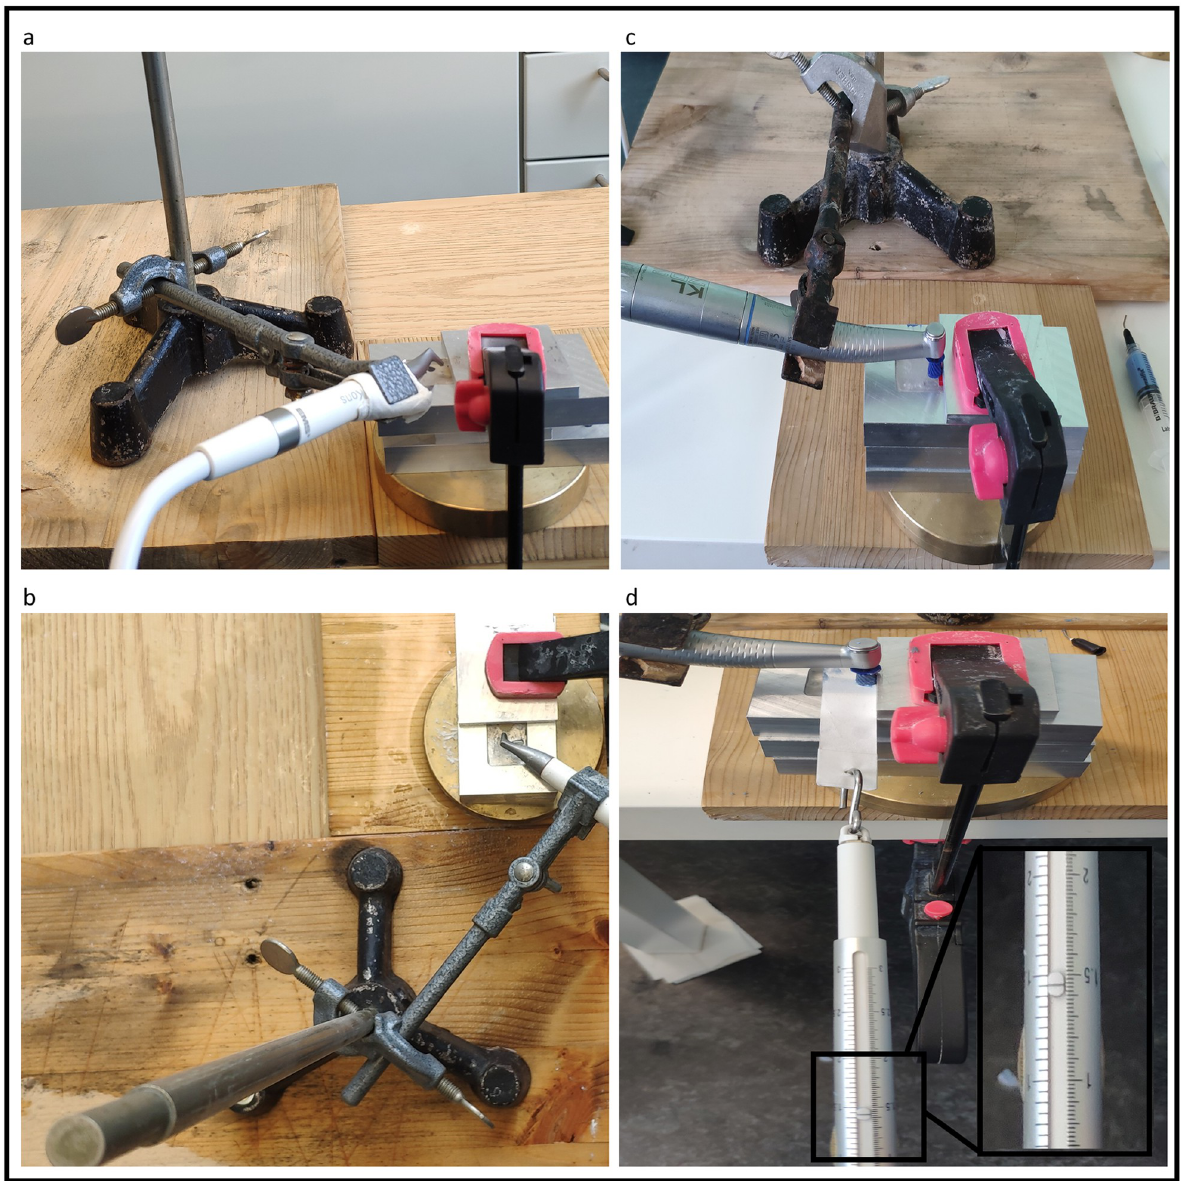
Fig 1. Constructions. Side and top view of the device construction for group AF (a-b) plus side and top view of the device construction for group CL